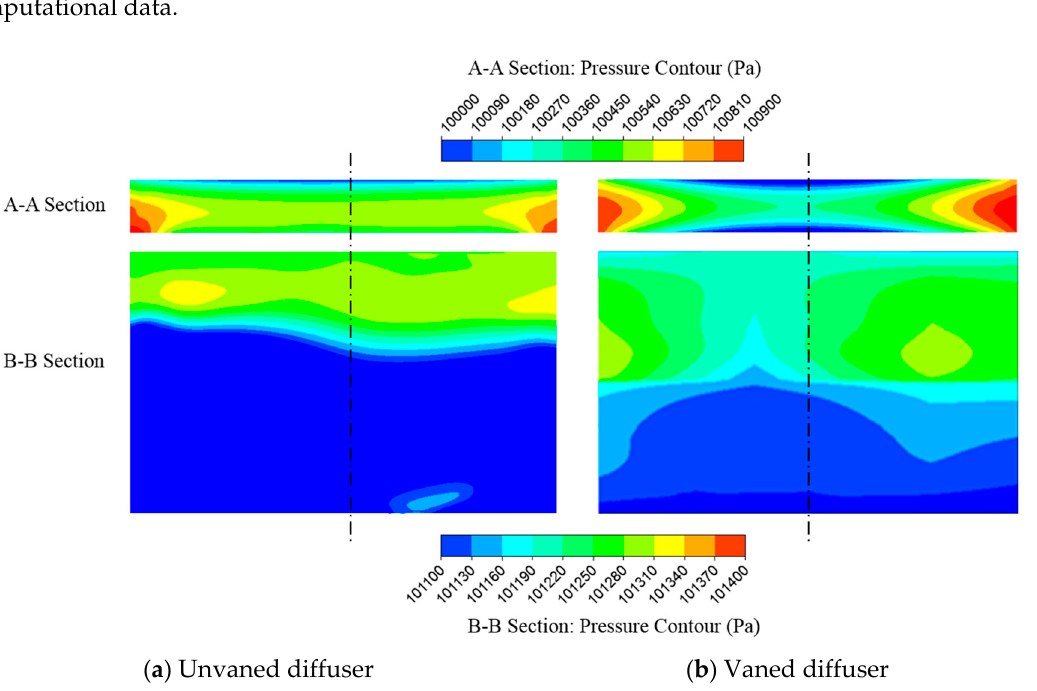
Figure 6. Pressure contours in the cross-section viewed in the downstream direction. (A-A section: diffuser throat, B-B section: diffuser exit).